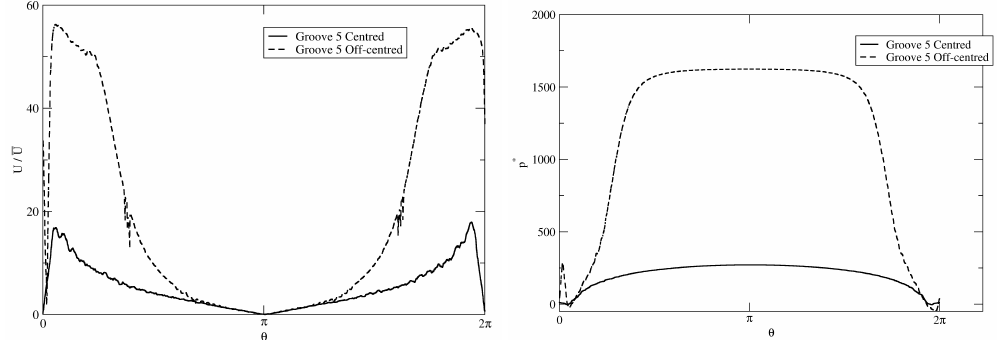
Figure 9. Dimensionless velocity distribution and dimensionless pressure distribution for groove 5 in position R5. Continuous lines are for centered piston and dashed lines are for off-centered pistons.